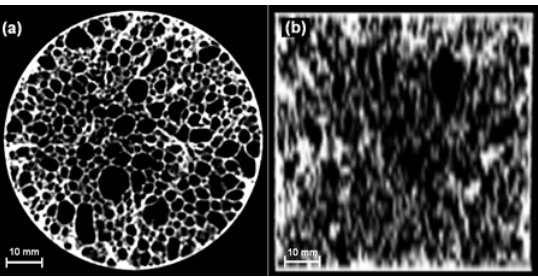
Figure 4. Tomographic slices of the 70/70 (690 kg/m 3 ) foam: ( a ) XY-plane and ( b )